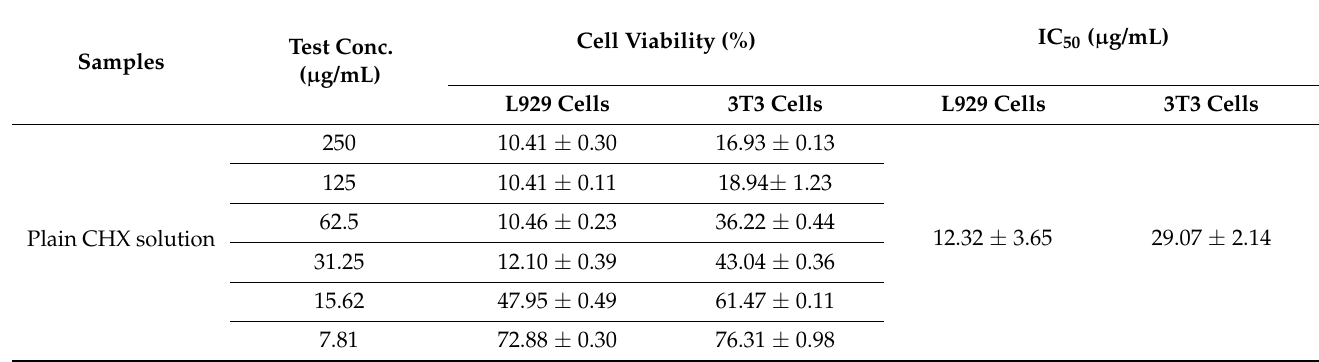
Table 5. Results of cell viability assay of plain CHX solution and liposomal